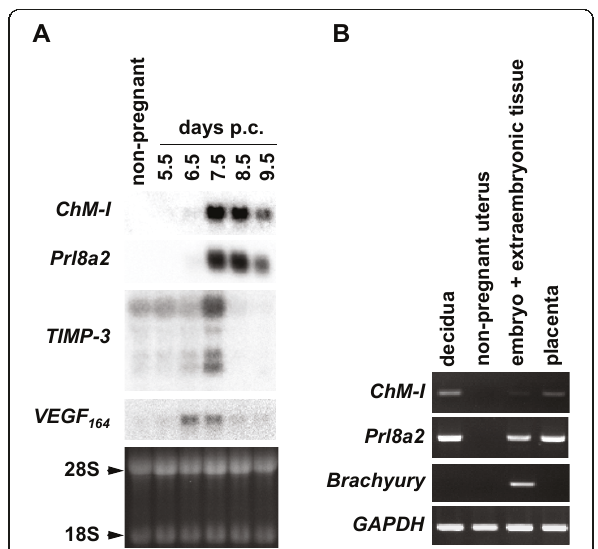
Figure 1 Expression of ChM-I in the mouse uterus during early pregnancy . (A) Northern blot analysis of ChM-I mRNA in the pregnant mouse uterus. Total RNA was extracted from pregnant mouse uteri (myometrium + decidua + embryo) and non-pregnant mouse uteri, separated on a denatured agarose gel, and transferred to a nylon membrane. The blots were then hybridized with a radio- labeled probe for ChM-I, Prl8a2, TIMP-3 , and VEGF-A 164 , respectively. The equivalent loading of RNA (15 μ g/lane) in each lane was verified by ethidium bromide staining. Arrowheads indicate the positions of the 28S and 18S ribosomal RNAs. (B) Total RNA was extracted from decidua (7.5 days p.c.), non-pregnant mouse uteri (8- week-old), embryos (7.5 days p.c., including extraembryonic tissues), and placenta (13.5 days p.c.). The decidual tissues were prepared by the removal of embryos and extraembryonic tissues from whole decidual capsules. One microgram of each total RNA preparation was reverse-transcribed, and the expression of ChM-I and marker genes ( Prl8a2 , a marker for trophoblasts and decidua; Brachyury , a marker for embryonic tissue) was analyzed by RT-PCR (30 cycles). GAPDH was used as an internal control. The data are representative of three independent